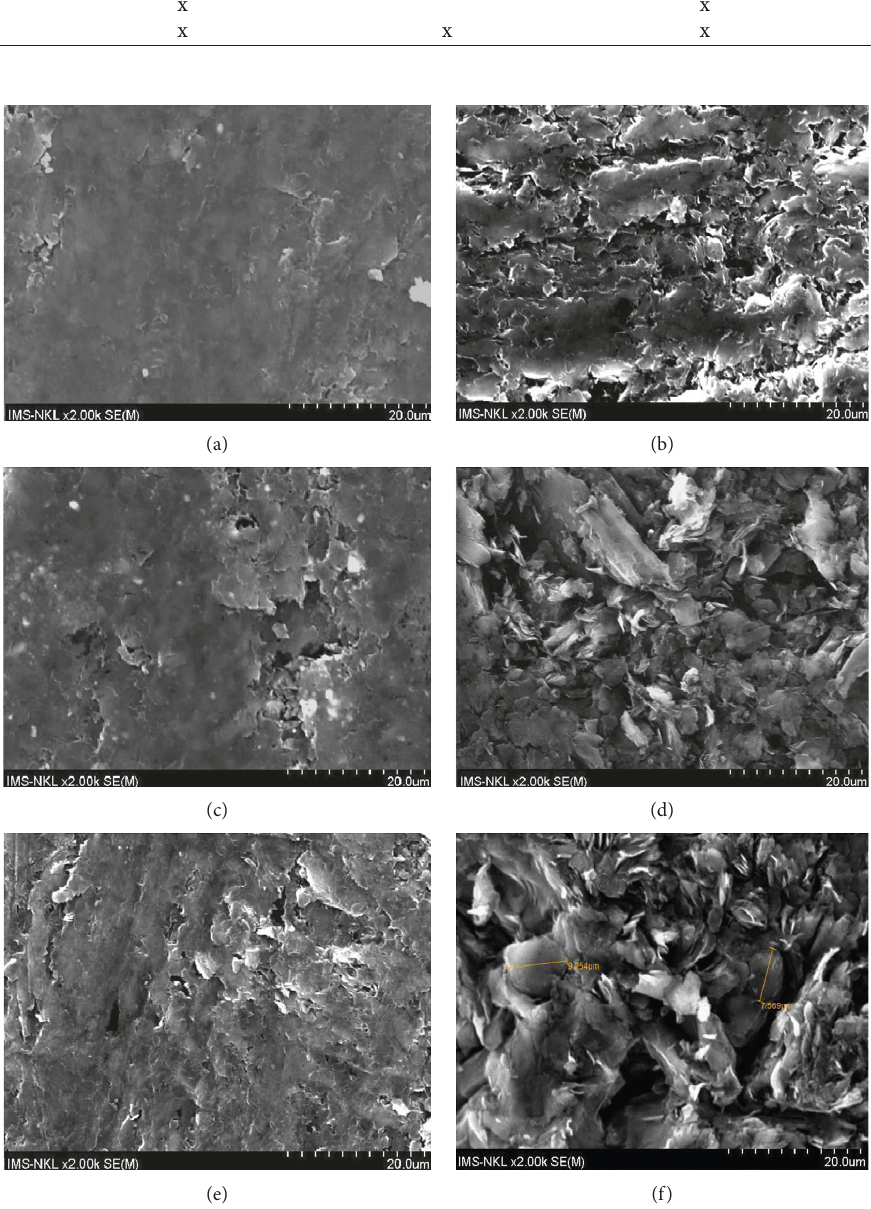
Figure 1: SEM images of composites before (left) and after (right) pyrolysis ( × 2,000): P (a, b), G/P (c, d), and G-CF/P (e,